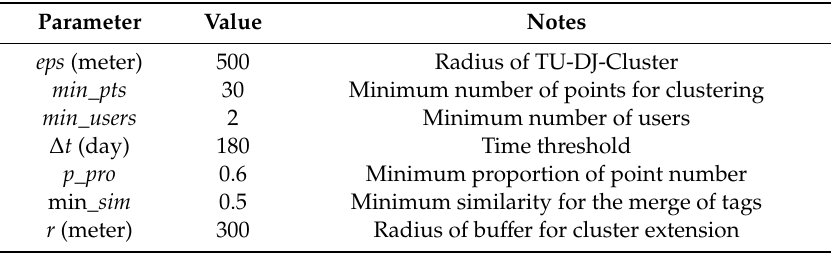
Table 1. The value of TU-DJ-Cluster’s parameters.